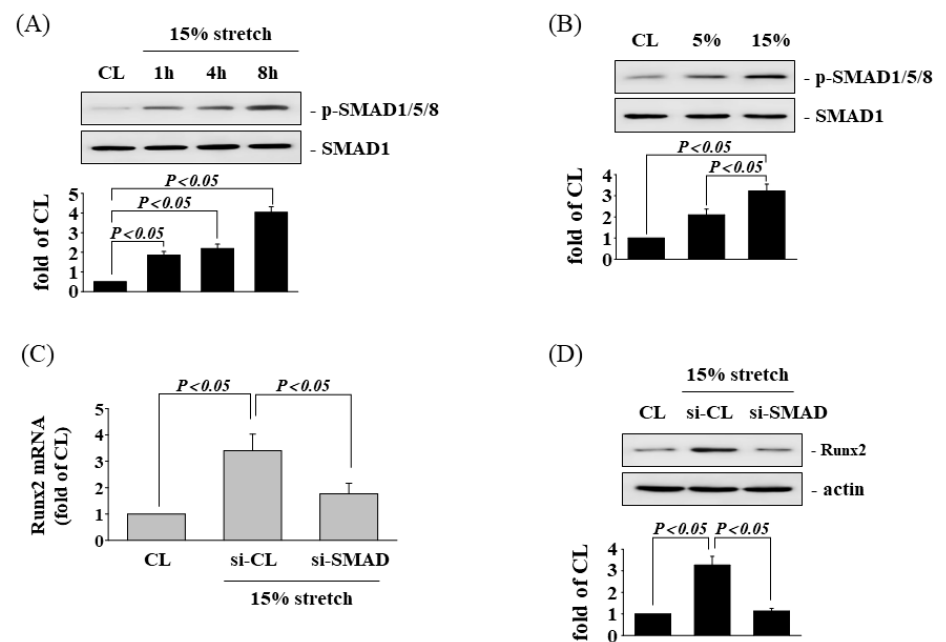
Figure 6. SAMD1/5/8 is involved in HCS-induced Runx2 expression. ( A ) Control or HCS-stimulated AF cells were maintained for the times indicated, and the phosphorylation of SMAD1/5/8 in these cells was determined using Western blotting. ( B ) The phosphorylation of SMAD1/5/8 in AF cells after 1 h of LCS (5%) or HCS (15%) stimulation was determined using a Western blot analysis. The results shown are representative of three independent experiments that gave similar results. ( C , D ) AF cells were kept as CL or subjected to 15% HCS for 8 h. Before being kept as CL or subjected to CS, AF cells were transfected with control siRNA (si-CL), or a specific siRNA of si-SMAD, and then exposed to HCS for 8 h. The mRNA ( C ) and protein ( D ) expression of Runx2 were examined by real-time PCR and Western blotting, respectively. The results are mean ± SD and are representative of three independent experiments (n = 3). Data statistics were completed with ANOVA followed by Scheffe’s test. The results were considered significant for p <